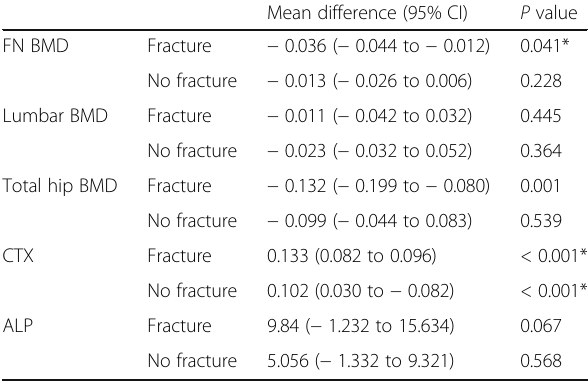
Table 3 The measurements difference at the end-point